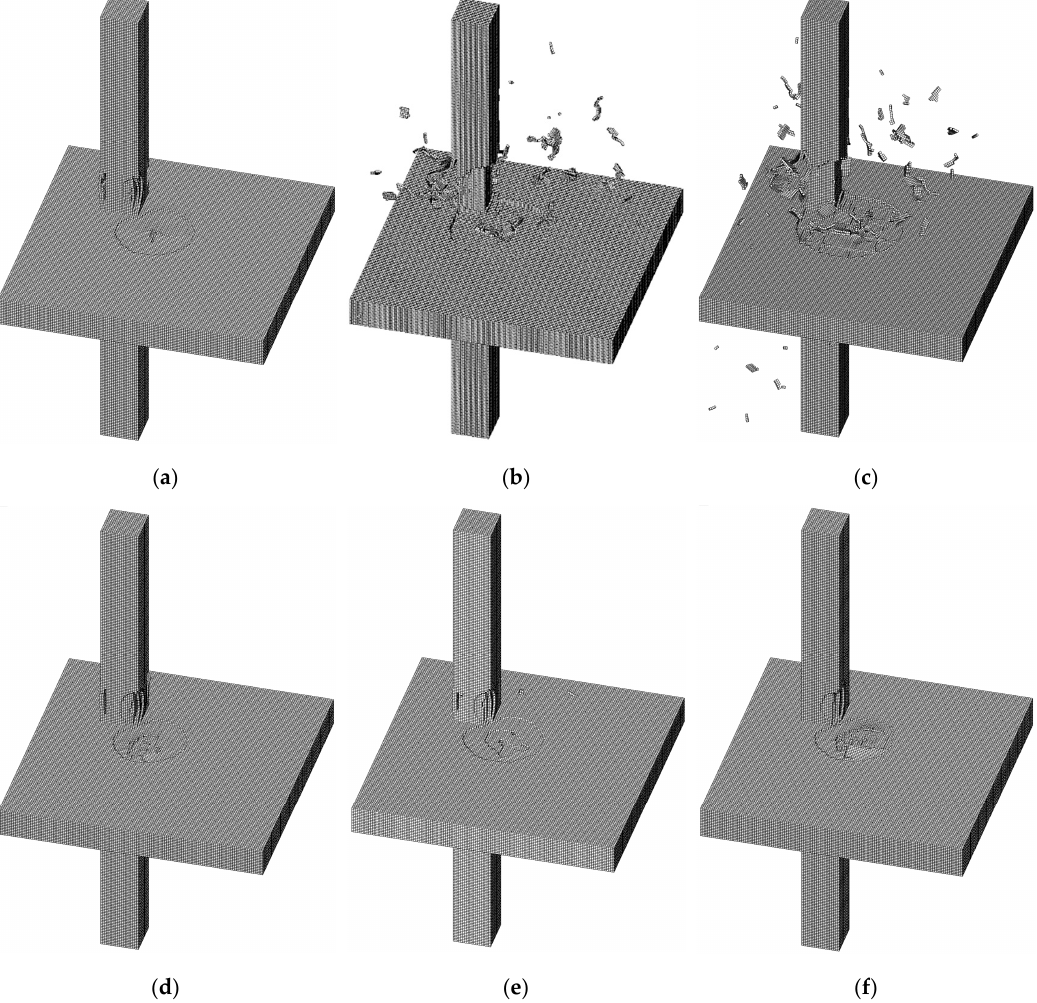
Figure 9. Failure shape for some verification analysis cases; ( a ) Case 3; ( b ) Case 6; ( c ) Case 7; ( d ) Case 8; ( e ) Case 10; ( f ) Case 13.